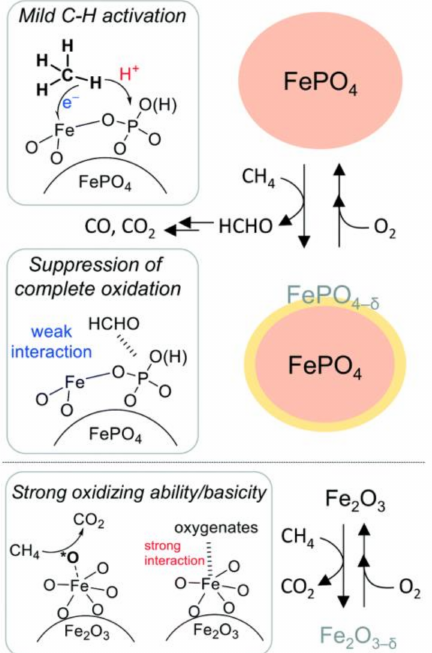
Figure 8. Proposed reaction mechanism for the oxidation of CH 4 over FePO 4 into HCHO with O 2 using FePO 4 -MA and complete oxidation of CH 4 over Fe 2 O 3 into CO 2 with O 2 using Fe 2 O 3 [70]. Copyright 2021, with permission from Royal Society of